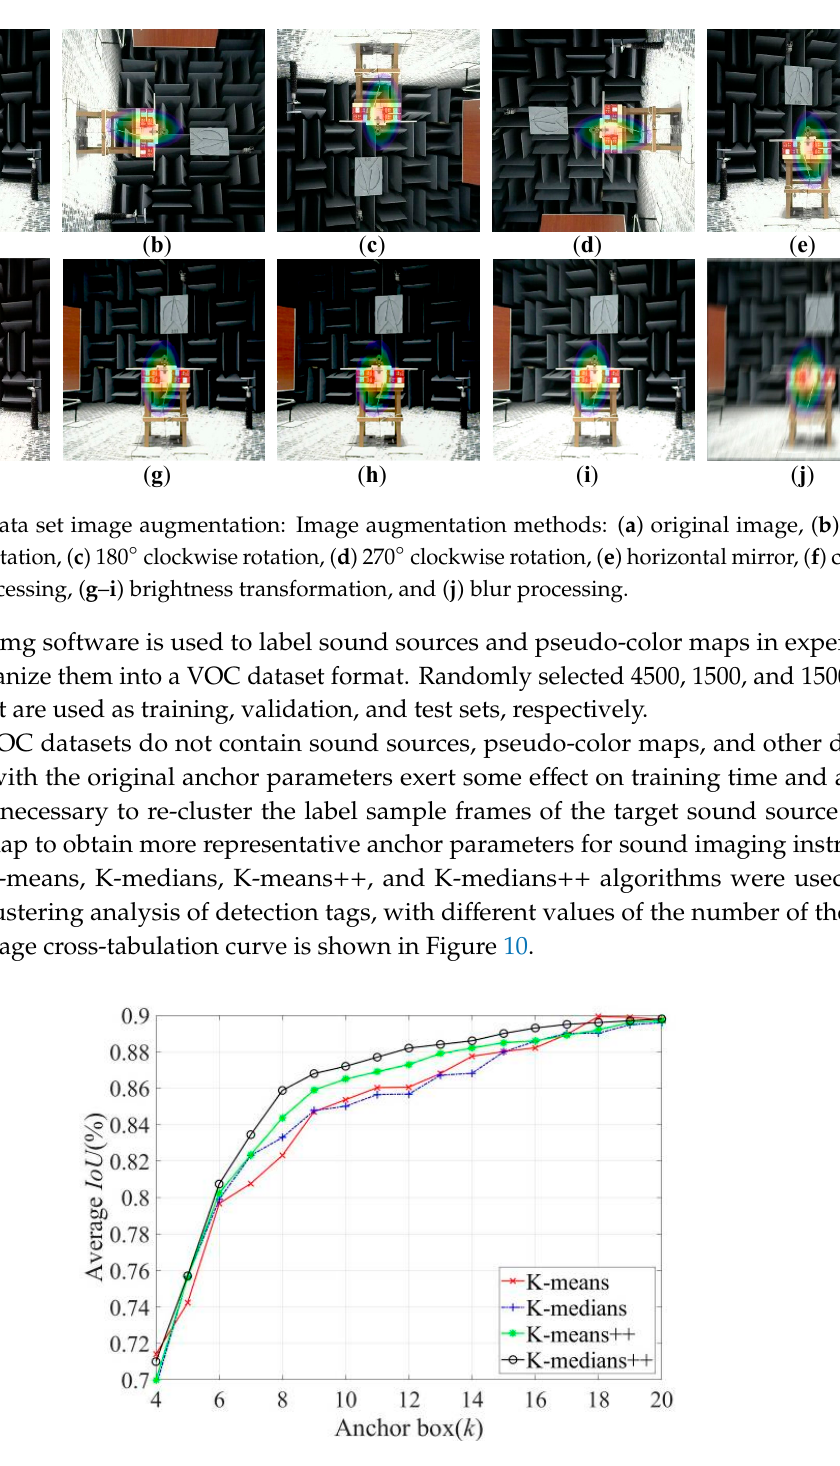
Figure 10. The average curve of the intersection ratio corresponding to different k values.